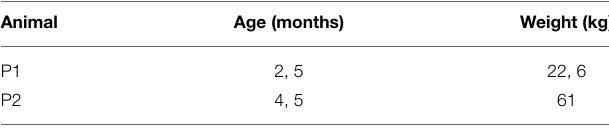
TABLE 1 | Age and weight of the pigs used for the longitudinal investigation.